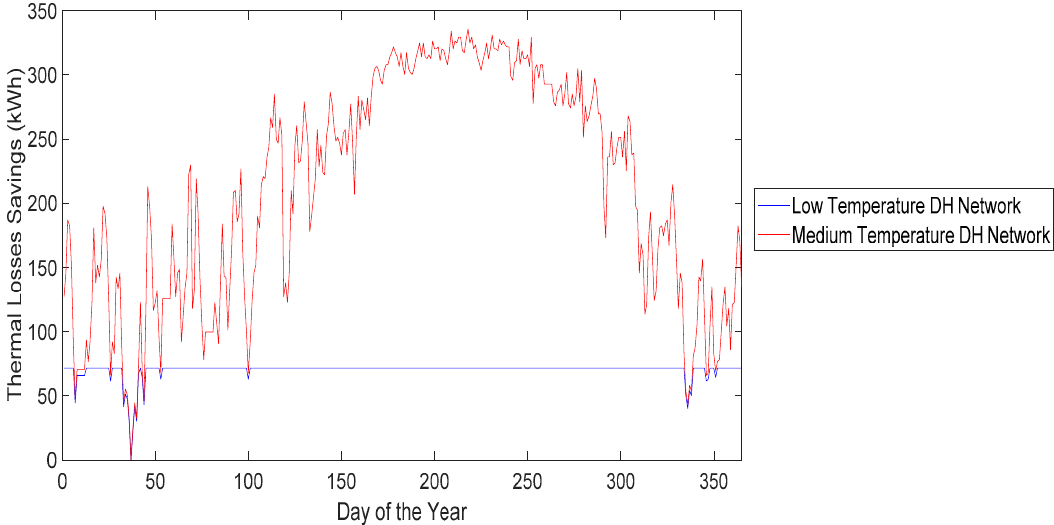
Figure 10. Energy savings in low and medium temperature networks operating at variable network temperatures.